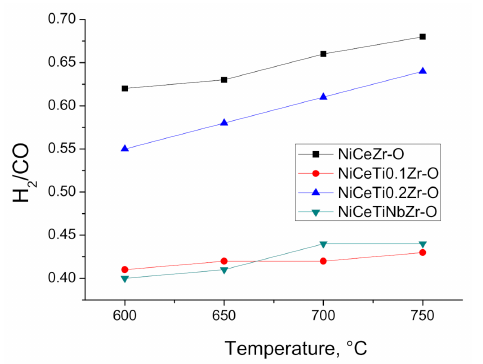
Figure 11. The dependences of H 2 /CO ratio on temperature for one-pot samples. Feed 15% CH 4 + 15% CO 2 + N 2 balance, contact time 10